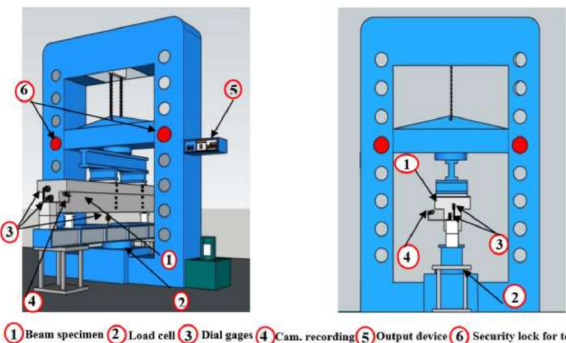
Figure 5: Test setup and